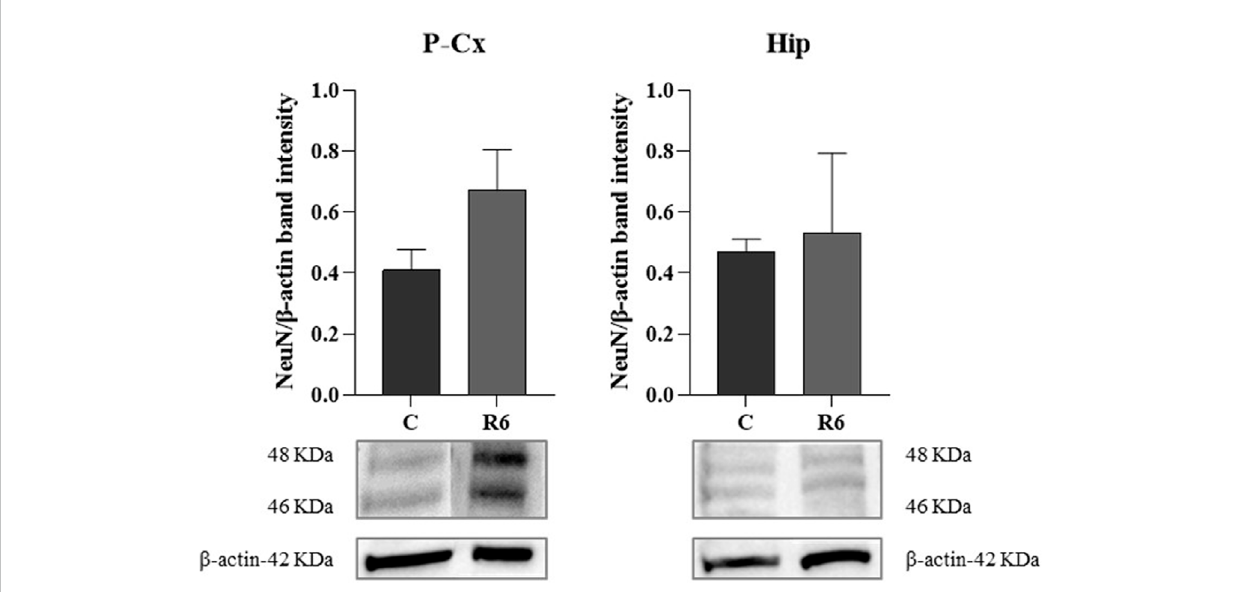
FIGURE 6 Western blot (WB) determinations of NeuN levels (i.e., neuronal marker) in brain extracts of parietal cortex (P-Cx) and hippocampus (Hip). Below each histogram, WB representative sample are shown for each experimental condition. Data are normalized by β -actin and expressed as mean ± S.E.M., n = 3. Experimental groups: C, control; R6, samples taken 6 h after Tb reached 35.5 ° C following ST (see Figure